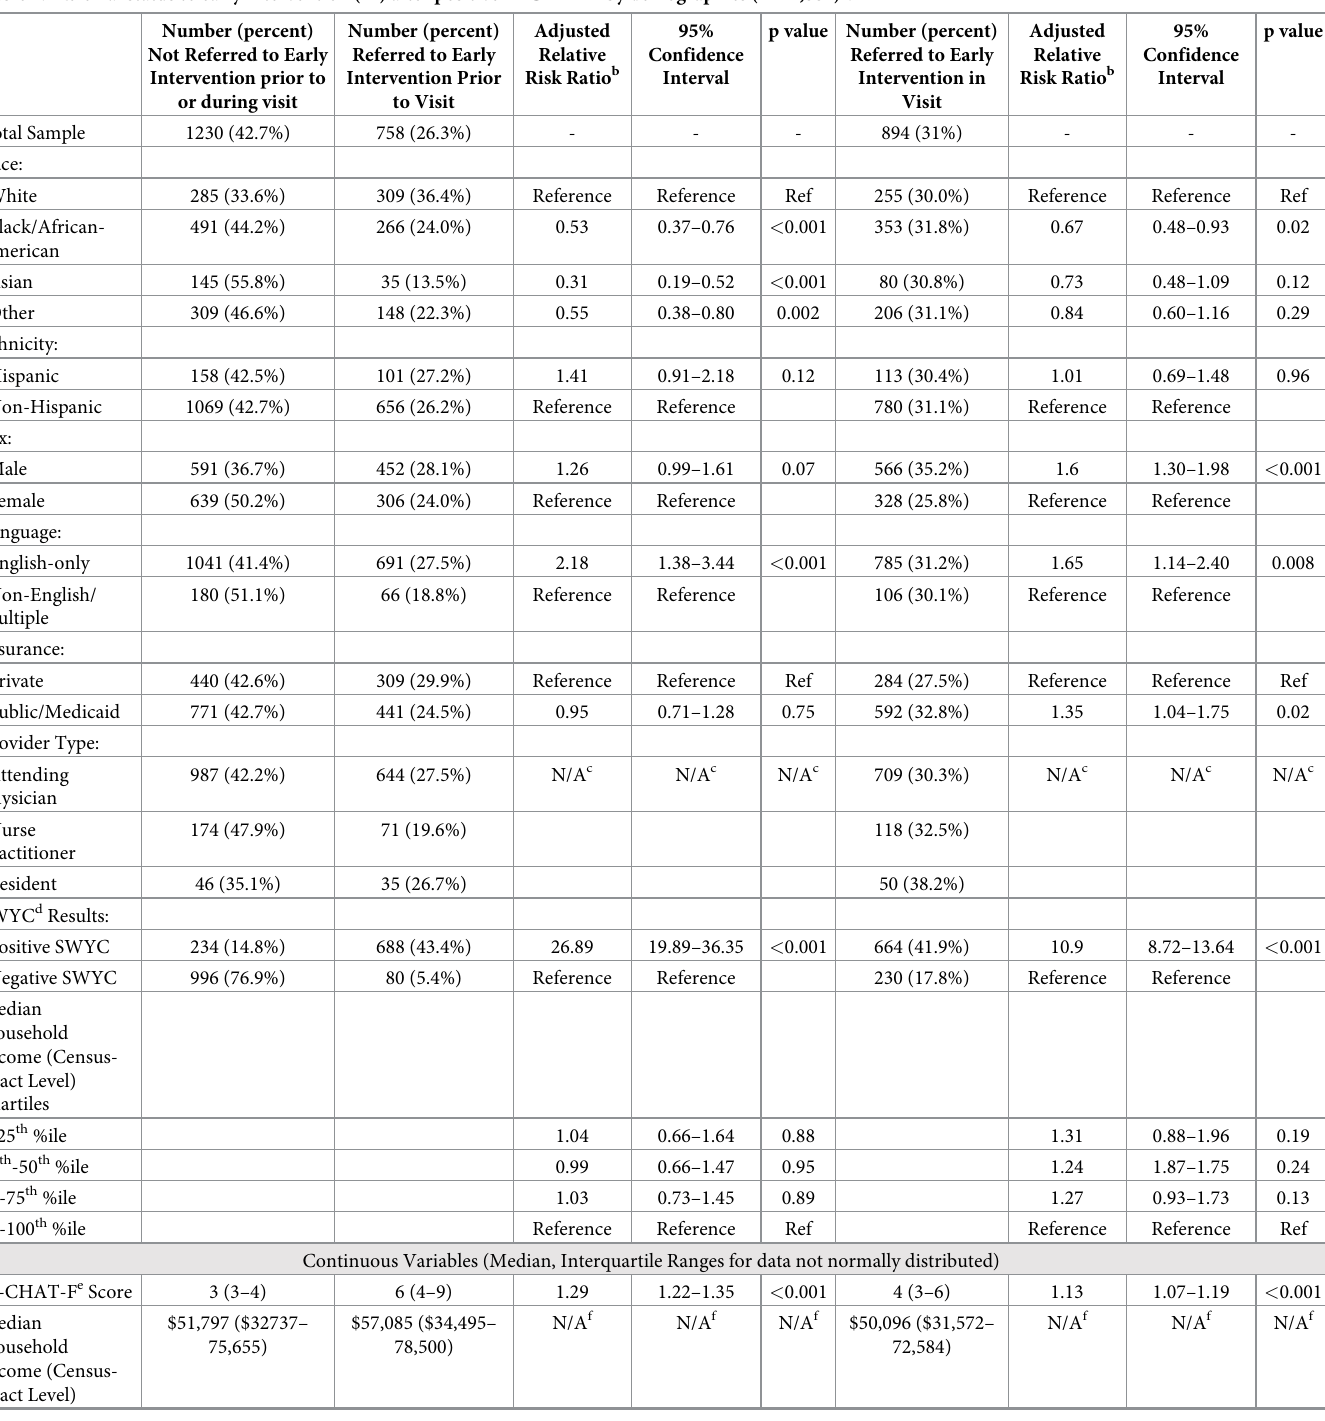
Table 4. Referral status to early intervention (EI) after positive M-CHAT-F by demographics (n = 2,882) a . Number (percent) Not Referred to